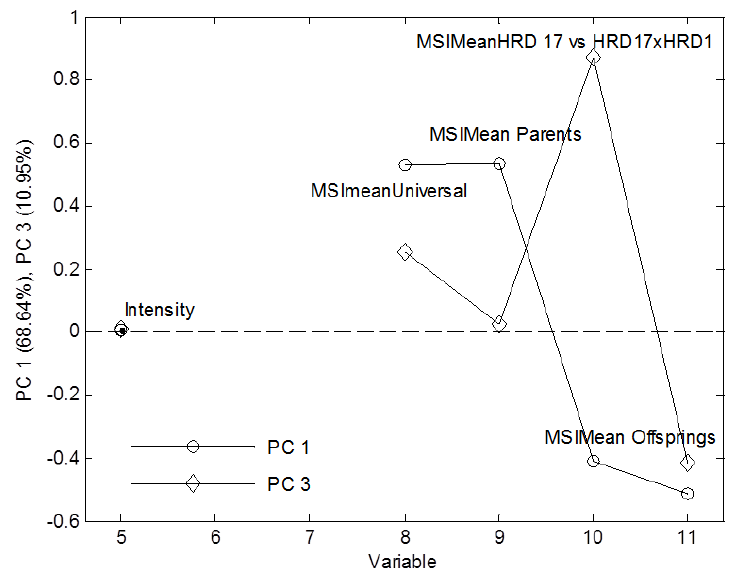
Figure 4. Loading plot obtained from PCA showing factors important for